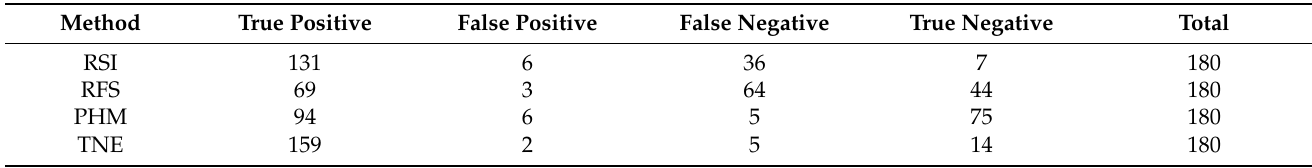
Table 3. Detection of laryngopharyngeal reflux ( n = 180).